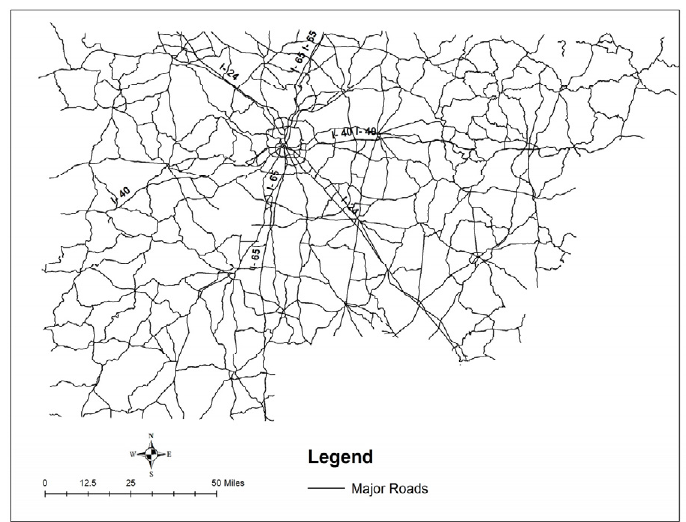
Fig. 3a: Input variable (Major Road) used in modeling inland wetlands’ vulnerability to human and natural stressors such as temperature increase and urban/agricultural expansion